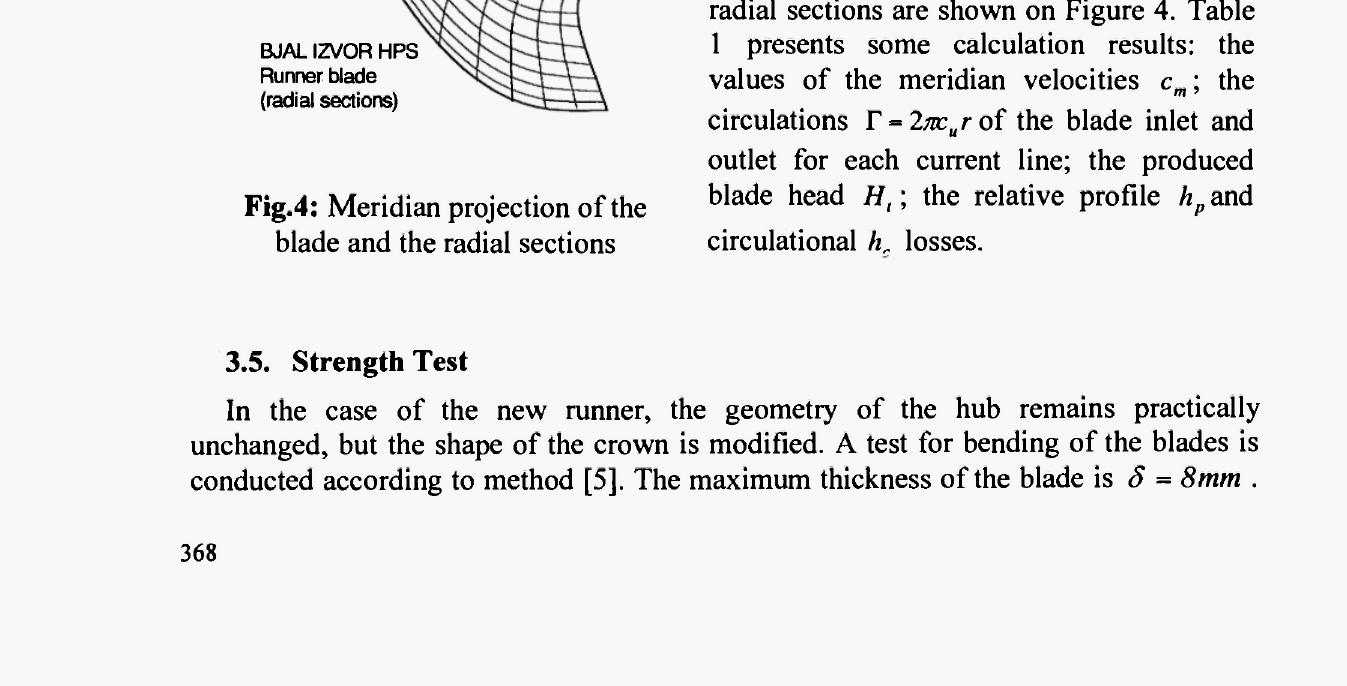
values of the meridian velocities c m ; the circulations r = 2^c u rof the blade inlet and outlet for each current line; the produced blade head H, ; the relative profile h p and Fig.4: Meridian projection of the circulational A_ blade and the radial sections